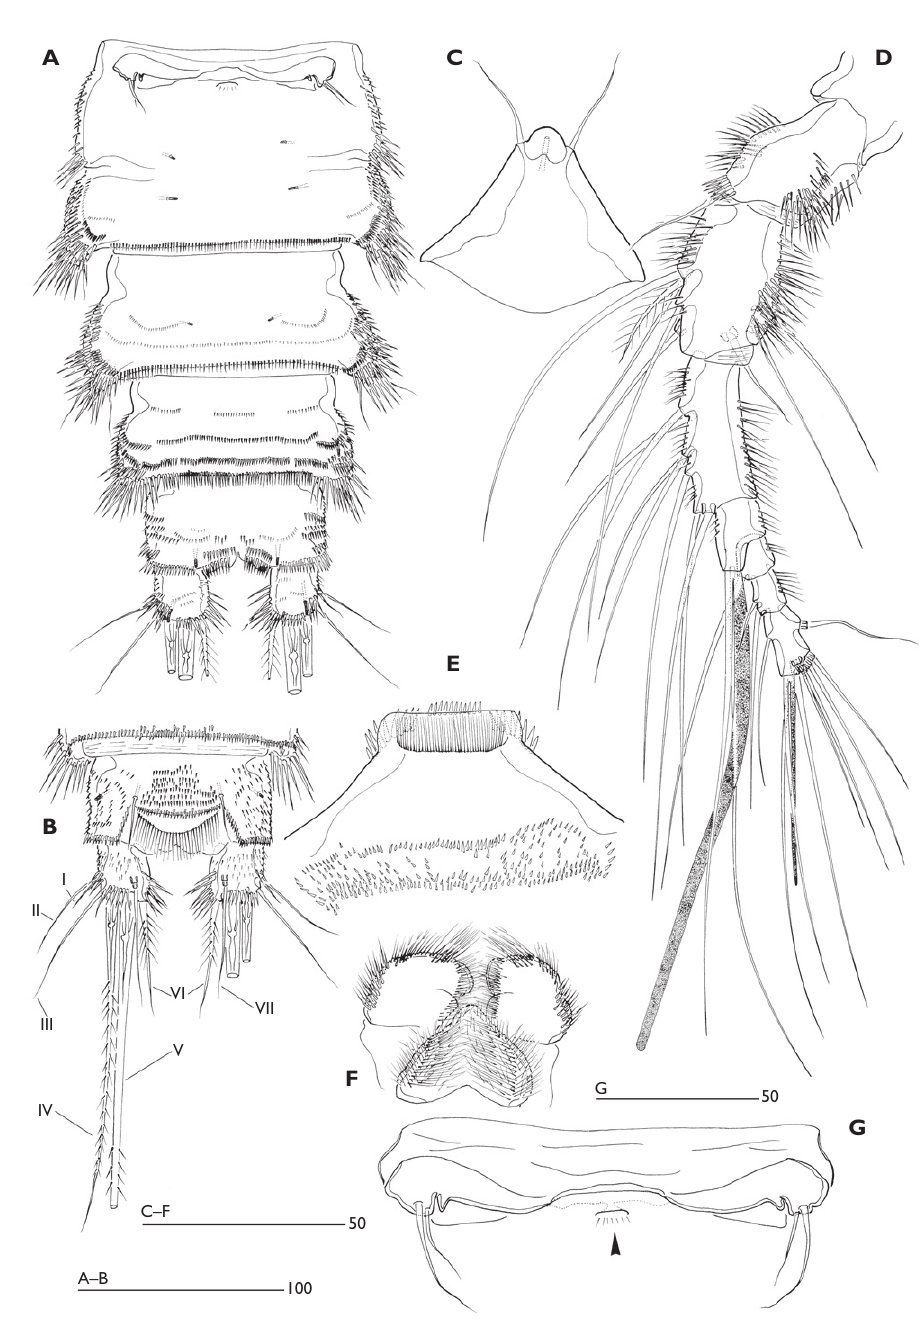
Figure 2. Marbefi a carthyi (Hamond, 1968), comb. n. ( ♀ ): A urosome, ventral [excluding P5-bearing somite] B anal somite and caudal rami, dorsal C rostrum, dorsal D antennule, ventral E labrum, anterior F paragnaths, anterior G genital area with P6 [copulatory pore